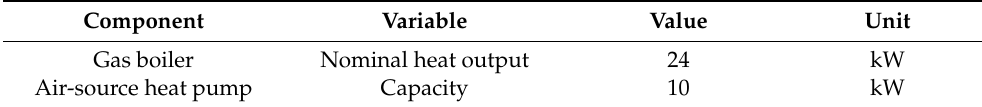
Figure 1. Life cycle assessment framework. Adapted from [48]. Table 7. Heating and cooling